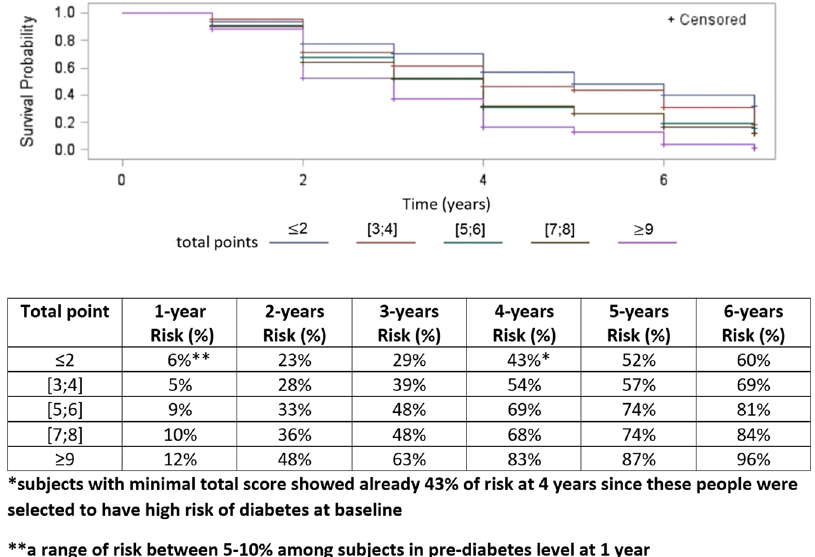
Figure 3. Diabetes risk distribution over time based on total risk scores among prediabetic subjects. * The total points obtained by our risk score system ranged from 0 to 12. We grouped the total points in classes to obtain reasonable risk values, because of the presence of small sample sizes for some total